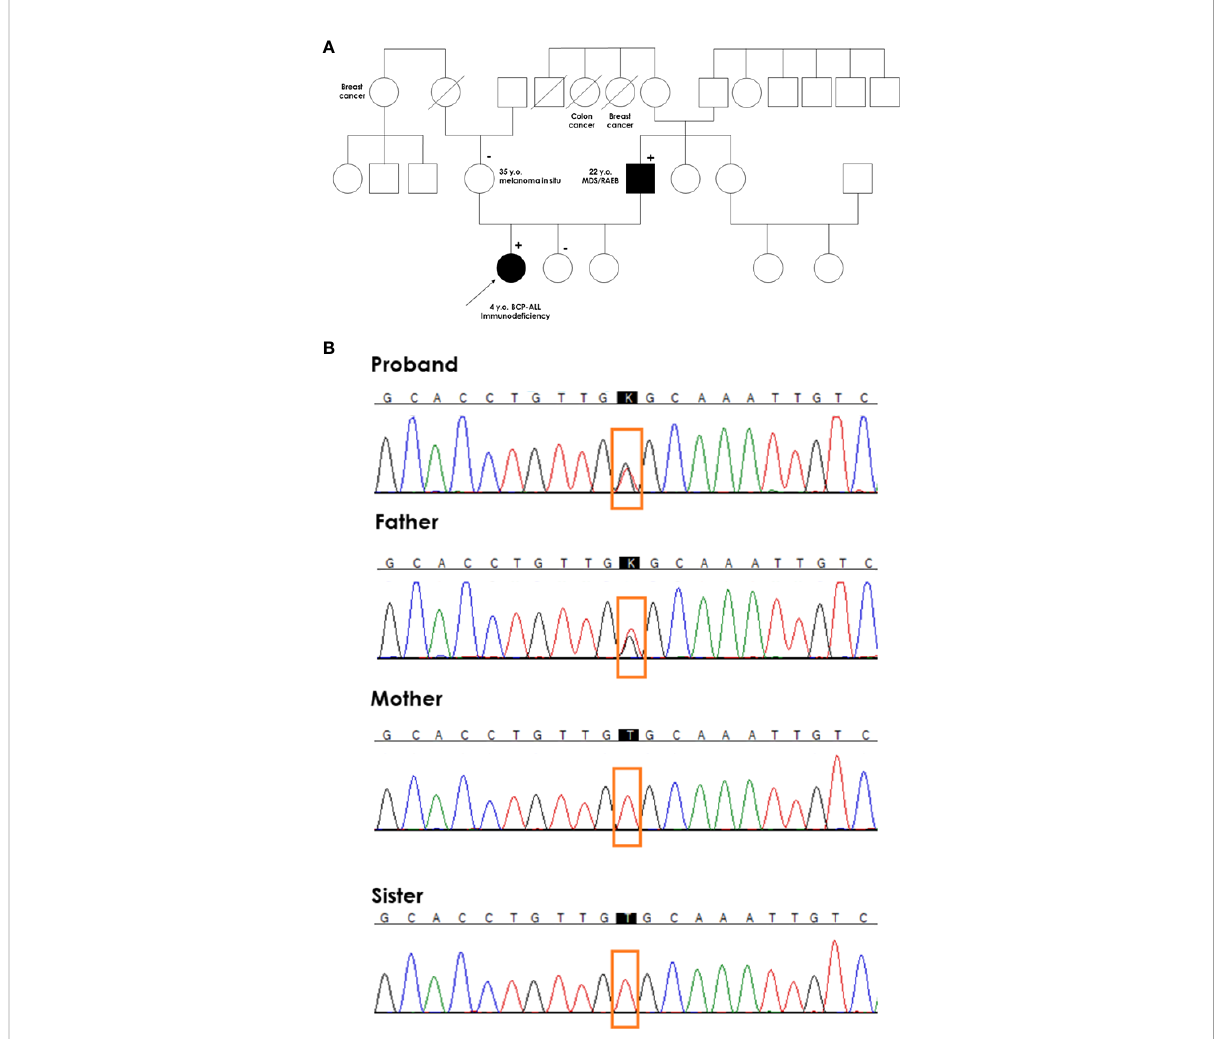
FIGURE 3 Genetic testing of the proband ’ s family. (A) A pedigree of the proband ’ s family. The proband with BCP-ALL had a germline mutation in exon 5 of the GATA2 gene (c.1047T>G, Cys349Trp) inherited from her father with MDS. (+) denotes heterozygous mutation carrier in the germline; (-) denotes wild-type in the germline. A diagonal line through a symbol indicates that the person is deceased (B) Chromatograms of germline GATA2 variant in the proband, and proband ’ s parents and